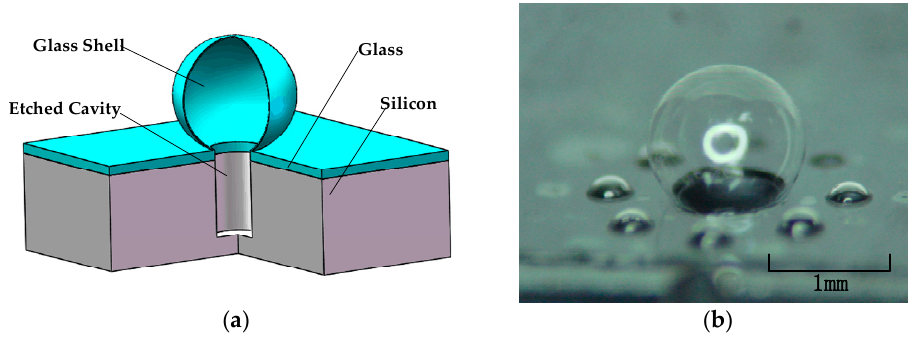
Figure 1. Demonstration diagram and micrograph of the glass hemisphere resonator (HSR): ( a ) cross-sectional view of the micro glass shell structure; ( b ) microphotograph of a glass-blown shell (height/diameter (H/D) = 0.79).